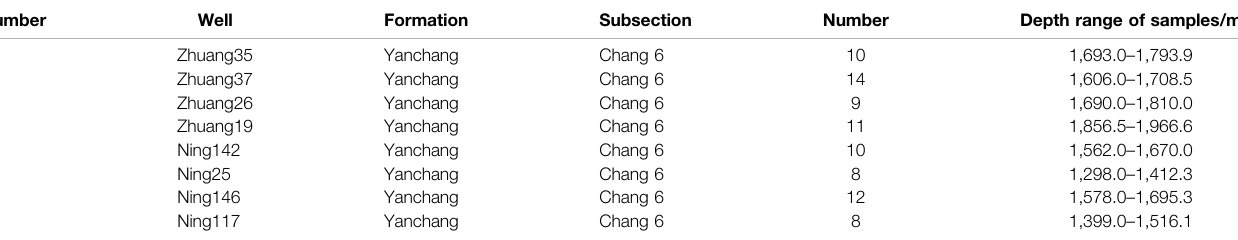
TABLE 2 | The number, well name, formation, subsection, and depth range of samples used in the fragment composition analysis and heavy mineral composition analysis under the microscope. See Figure 1 for the location of wells. Number Well Formation Subsection Number Depth range of